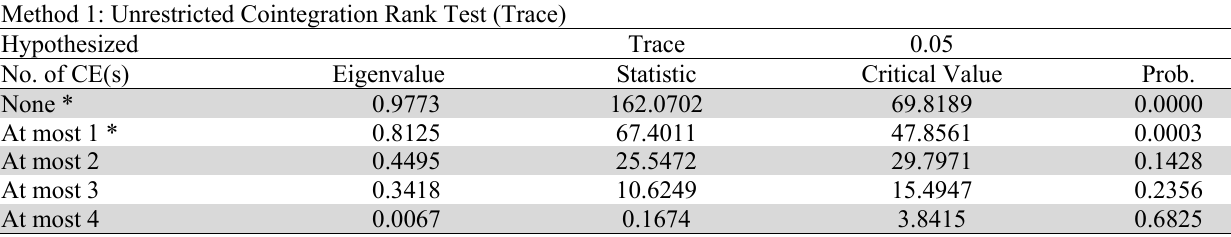
Results of the Johansen cointegration test Method 1: Unrestricted Cointegration Rank Test (Trace)